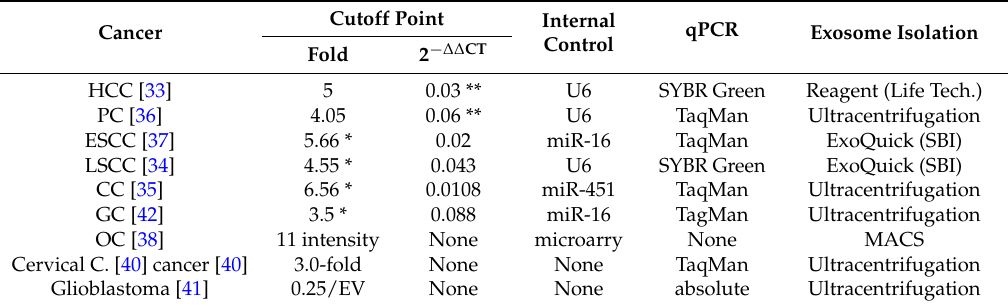
Table 2. The cutoff value and internal control of exosomal miR ‐ 21.